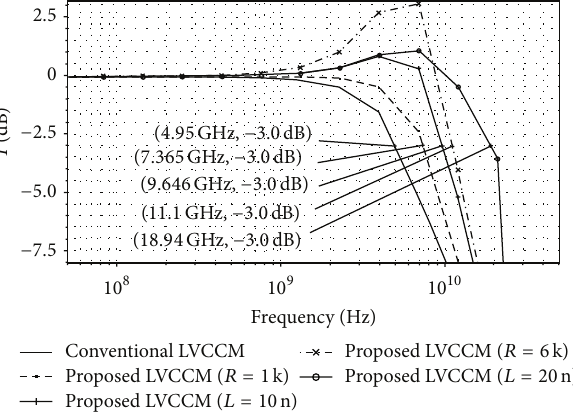
Figure 9: Frequency responses of designed